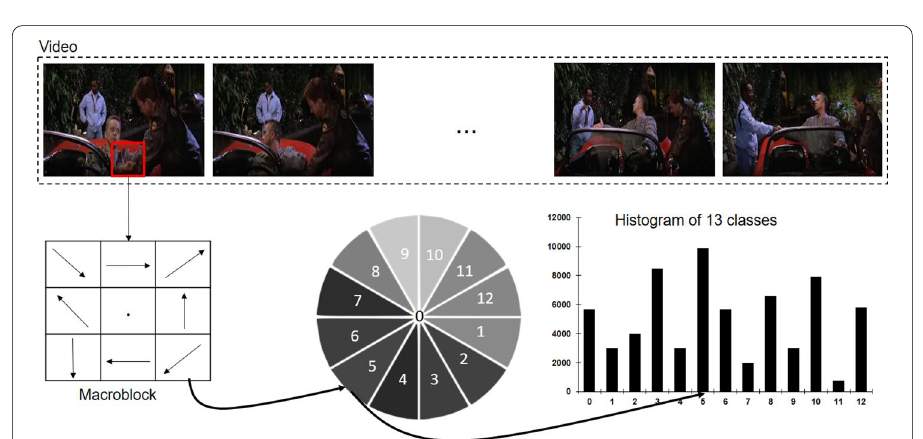
Fig. 4 Motion vector